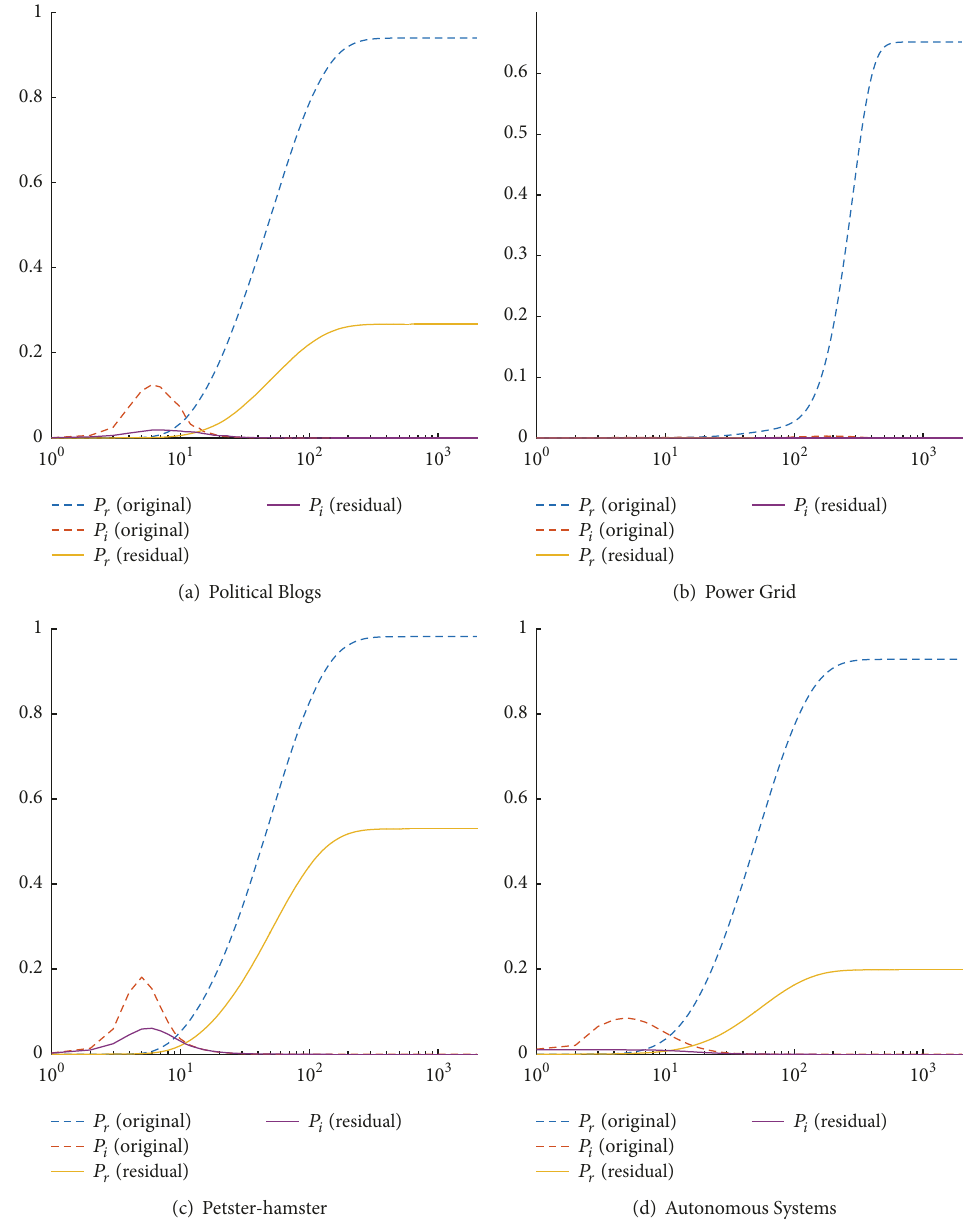
Figure 5: The spreadability of the networks before and after the removing of 10% edges by HPI-Ncut algorithm. The 𝑥 -axis is the time units. 𝑃 𝑃 𝑖 is the number of infected entities and 𝑟 is the number of recovered entities in the network. In the SIR model, the infection rate the recovery rate is 0.02, and the basic reproduction number is 5. All the results are the average of 100 times independent runs. It is worth noting that the size of GCC of the Power Grid network is only 54 after removing 10% of links by HPI-Ncut